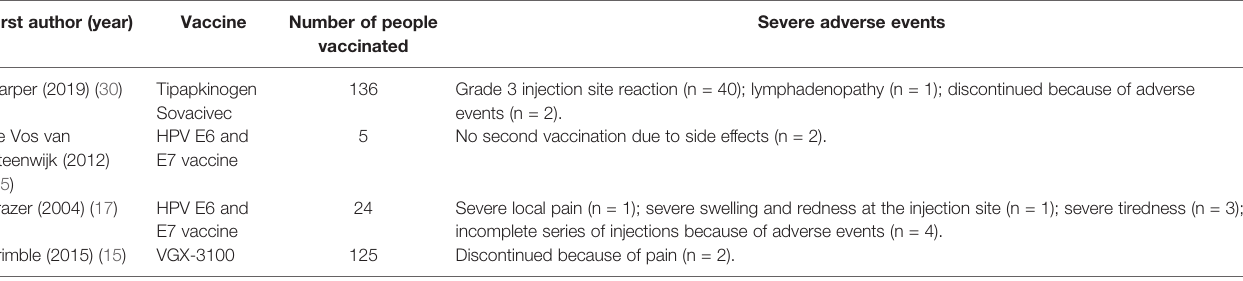
TABLE 5 | Severe adverse events reported for therapeutic vaccines for precancerous cervical